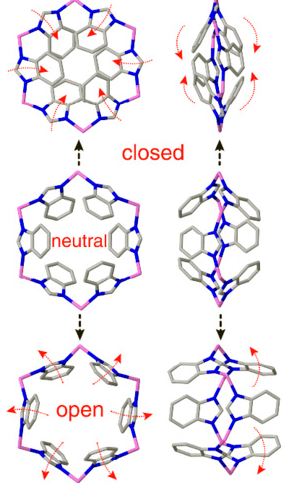
Figure 18. Illustration of low-energy vibration mode in ZIF-7, causing pore opening and closing. Reproduced with permission from [60]. Copyright American Physical Society, 2014.